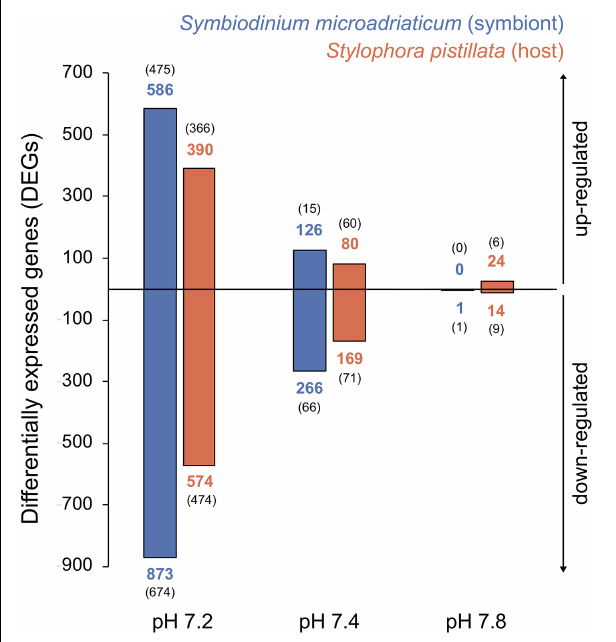
FIGURE 3 | Barplot showing number of differentially expressed genes (DEGs) for the symbiont (blue) and coral host (orange) across pH treatments compared to the control. Numbers in bold indicate the total number of DEGs for each category whilst numbers in parenthesis show unique genes (exclusive to that treatment). Top and bottom panels depict direction of the change, up- and down-regulation, respectively.